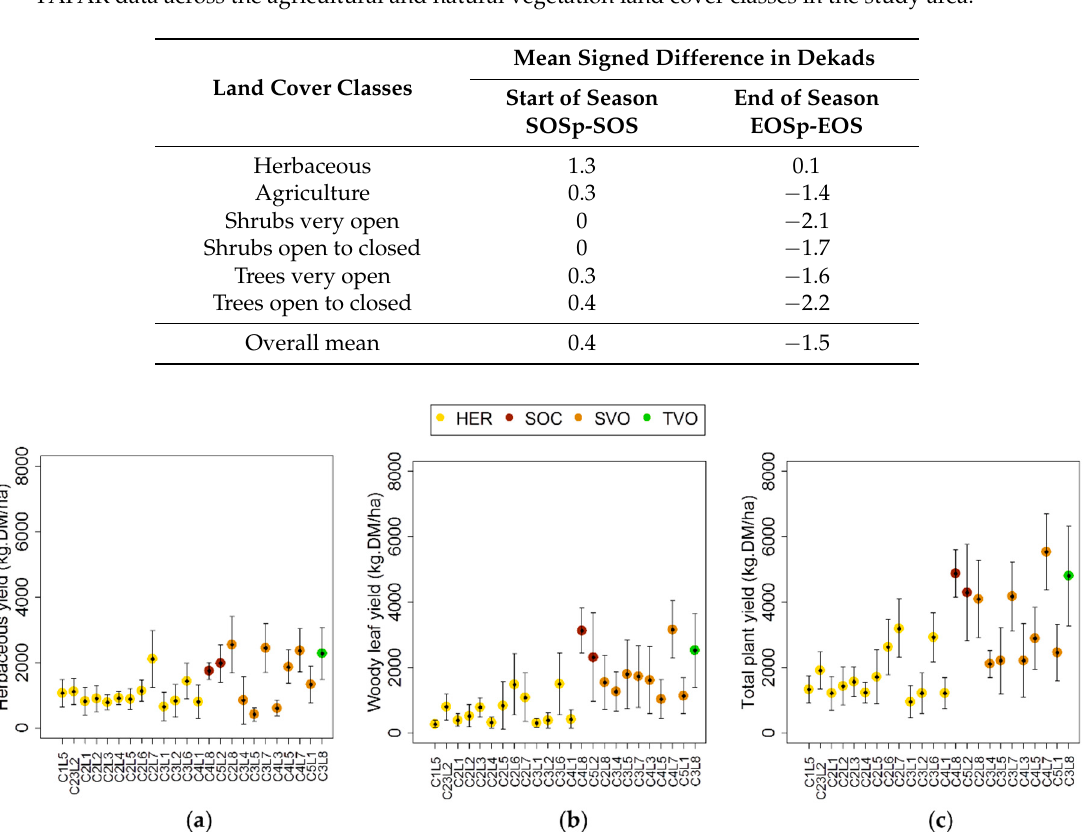
Table A2. Mean signed difference (in dekads) between onset metrics calculated from rainfall and FAPAR data across the agricultural and natural vegetation land cover classes in the study area.